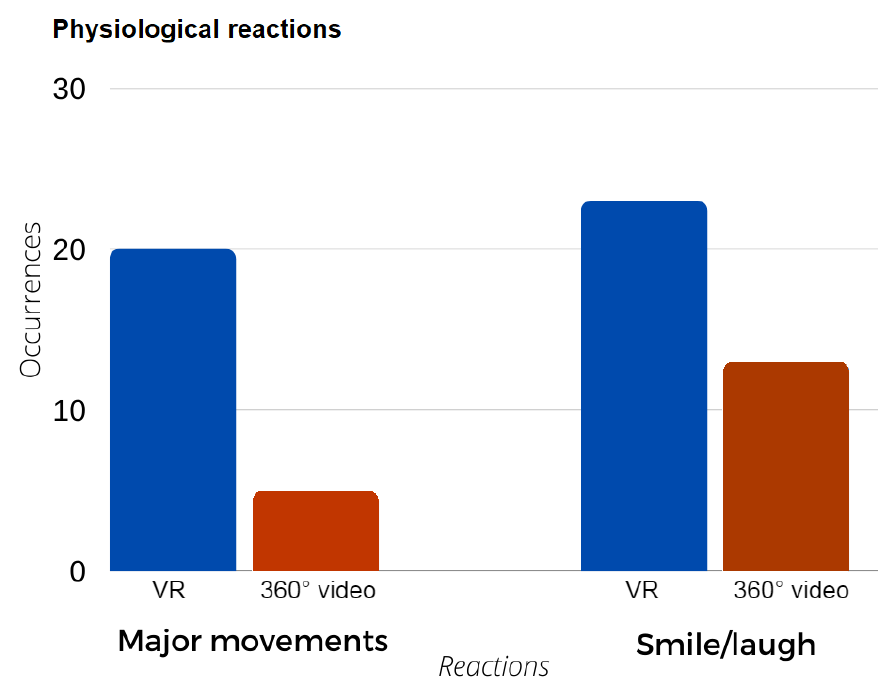
Figure 5. Physiological reactions comparative between VR and 360° videos.